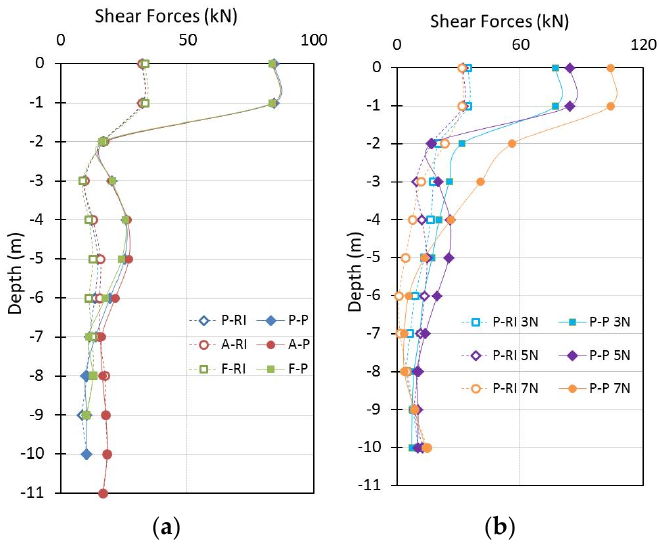
Figure 14. Shear forces in rigid inclusion and pile systems with different support conditions. ( a ) 5- storey Building; ( b ) 3-, 5- and 7-storey Buildings.